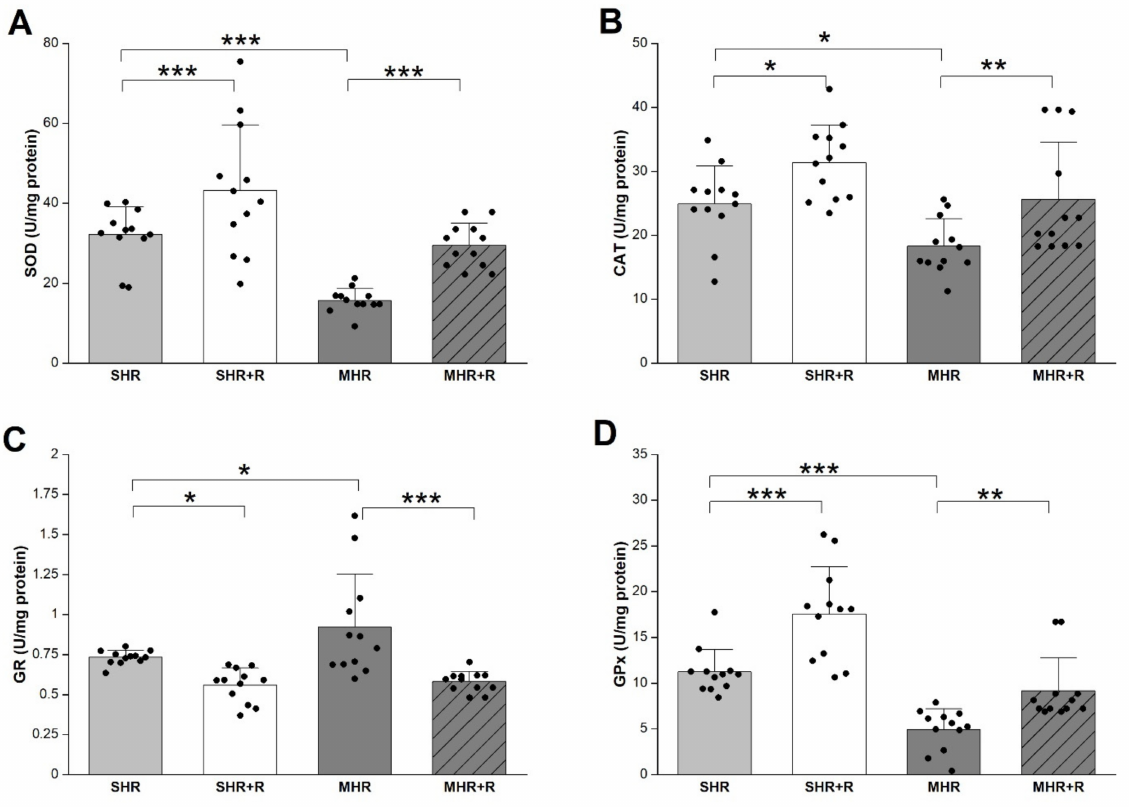
Figure 3. Antioxidative enzyme SOD-superoxide dismutase ( A ); CAT-catalase ( B ); GR-glutathione reductase ( C ) and GPx-glutathione peroxidase ( D ) in experimental groups. SHR-spontaneously hypertensive rat, SHR + R-spontaneously hypertensive treated with resveratrol; MHR-malignant hypertensive rat; MHR + R-malignant hypertensive rat treated with resveratrol. Values are means ± SD. ***, **, * indicate p < 0.001, 0.01, 0.05.